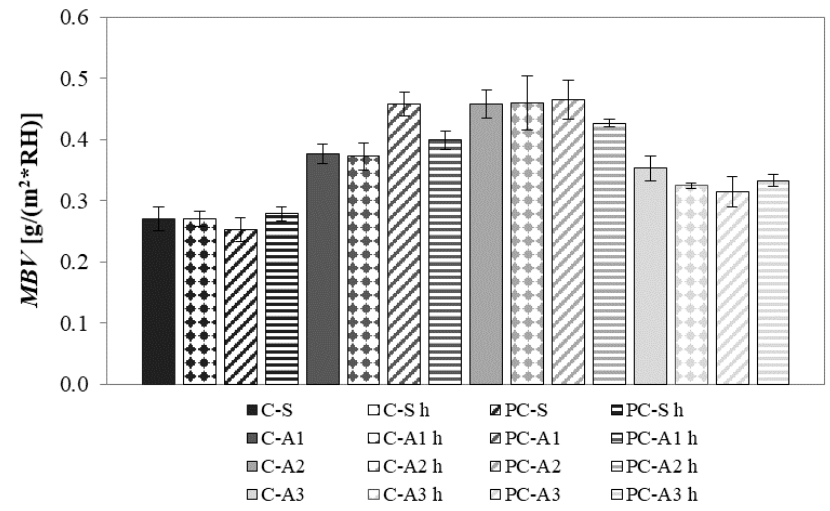
Figure 10. Moisture buffering value ( MBV ) of mortars.